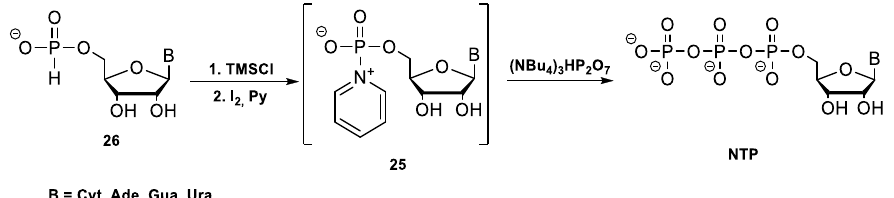
Figure 3. Homodinucleotides obtained by Sun et al. via pyridinium phosphobetaine intermediates. Recently, Romanowska et al. described the use of orthophosphoric acid as a nucleo- phile in the reaction with N -pyridiniumphosphonate 25 as a simple and convenient method for the preparation of various ribo- and deoxyribonucleoside diphosphates and their analogs. The use of orthophosphoric acid instead of lipophilic phosphate salts (e.g., tetrabutylammonium salts) greatly simplified the purification process of the NDPs ’ syn- thesis [92]. 3. Anti-HIV Pronucleotides – Nucleotide Reverse-Transcriptase Inhibitors (NtRTIs) The antiviral activity of anti-HIV pronucleotides is based on the presence in its struc- ture of 2 ′ ,3 ′ - dideoxynucleosides (ddNs), which, due to the lack of the 3′ -OH function in the dideoxynucleoside moiety, terminates the process of reverse transcription after the incorporation of a nucleotide analog into the growing viral DNA chain. This inhibits the synthesis of viral DNA and prevents virus replication (Scheme 16) [93]. Modified nucleo- sides are usually not biologically active as such, and must be phosphorylated in the cell to the appropriate 5 ’ -triphosphate in order to exert a therapeutic effect [4].